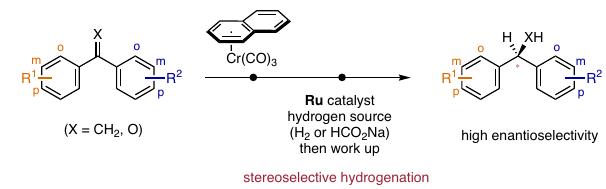
c . Relay strategy for asymmetric synthesis of gem -diaryl motifs (This work)